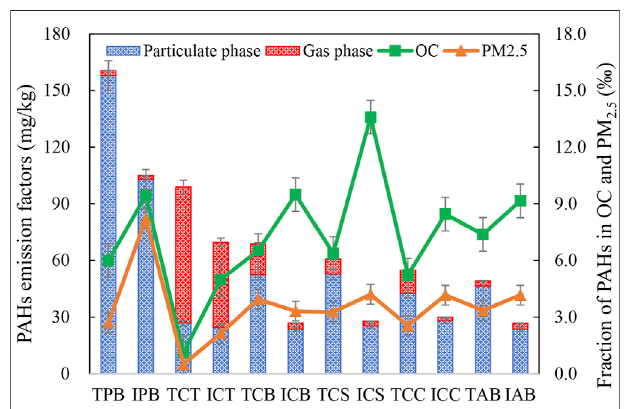
FIGURE2| PAHEFsandthefractionofparticlesPAHsinPM 2.5